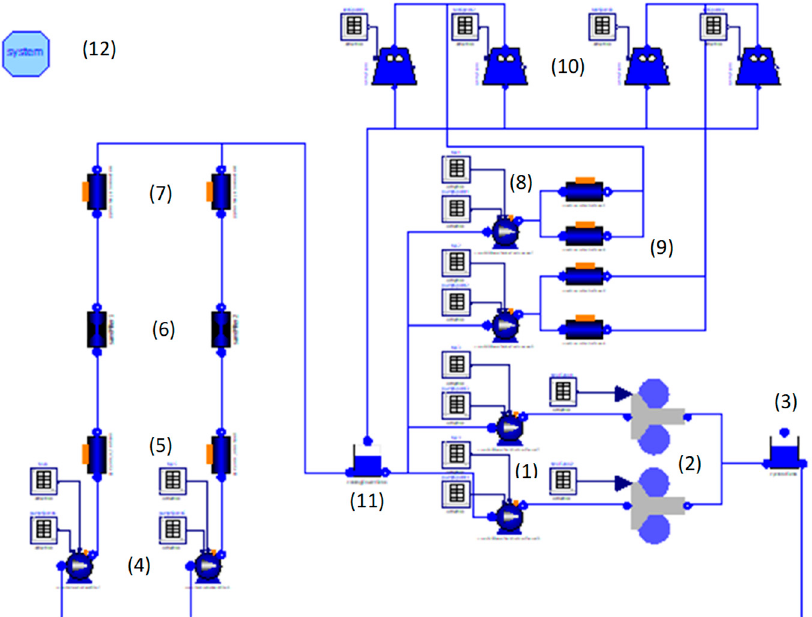
Figure 2. Diagram of the circuit of a steel wire processing plant in OpenModelica (Legend: (1) Pump Group 1, (2) Hot Rolling Mills, (3) Cyclone Tank, (4) Pump Groups 2, (5) Pipes from pumps to filters, (6) Sand Filters, (7) Pipes from filters to tank, (8) Pump Group 3, (9) Pipes from pumps to cooling towers, (10) Cooling Towers, (11) Cold Water Tank, (12) Reference System).